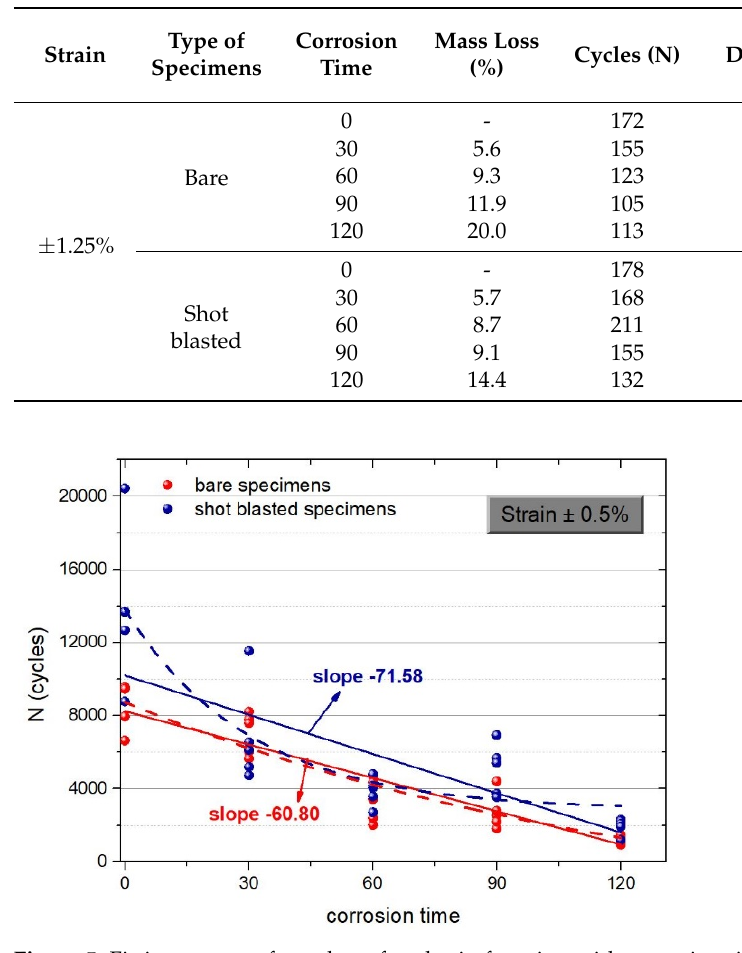
Table 9. Results of LCF tests with free length 6Ø conducted on bare and shot blasted specimens (in non-corroded and corroded conditions) for imposed deformation ± 1.25%.